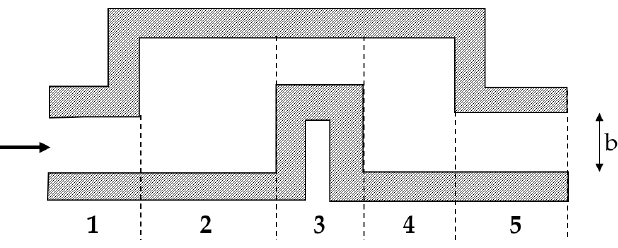
8 of 17 Figure 3. Constant radius test trajectory. Once the vehicles are on the circular path, the virtual drivers accelerate from 30 to 100 km/h following a stepwise constant law, with a step of 5 km/h, while ensuring that